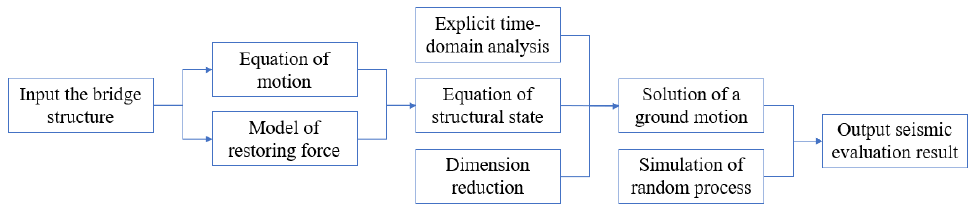
Figure 1. Flowchart of the proposed approach to perform nonlinear stochastic dynamic analysis.